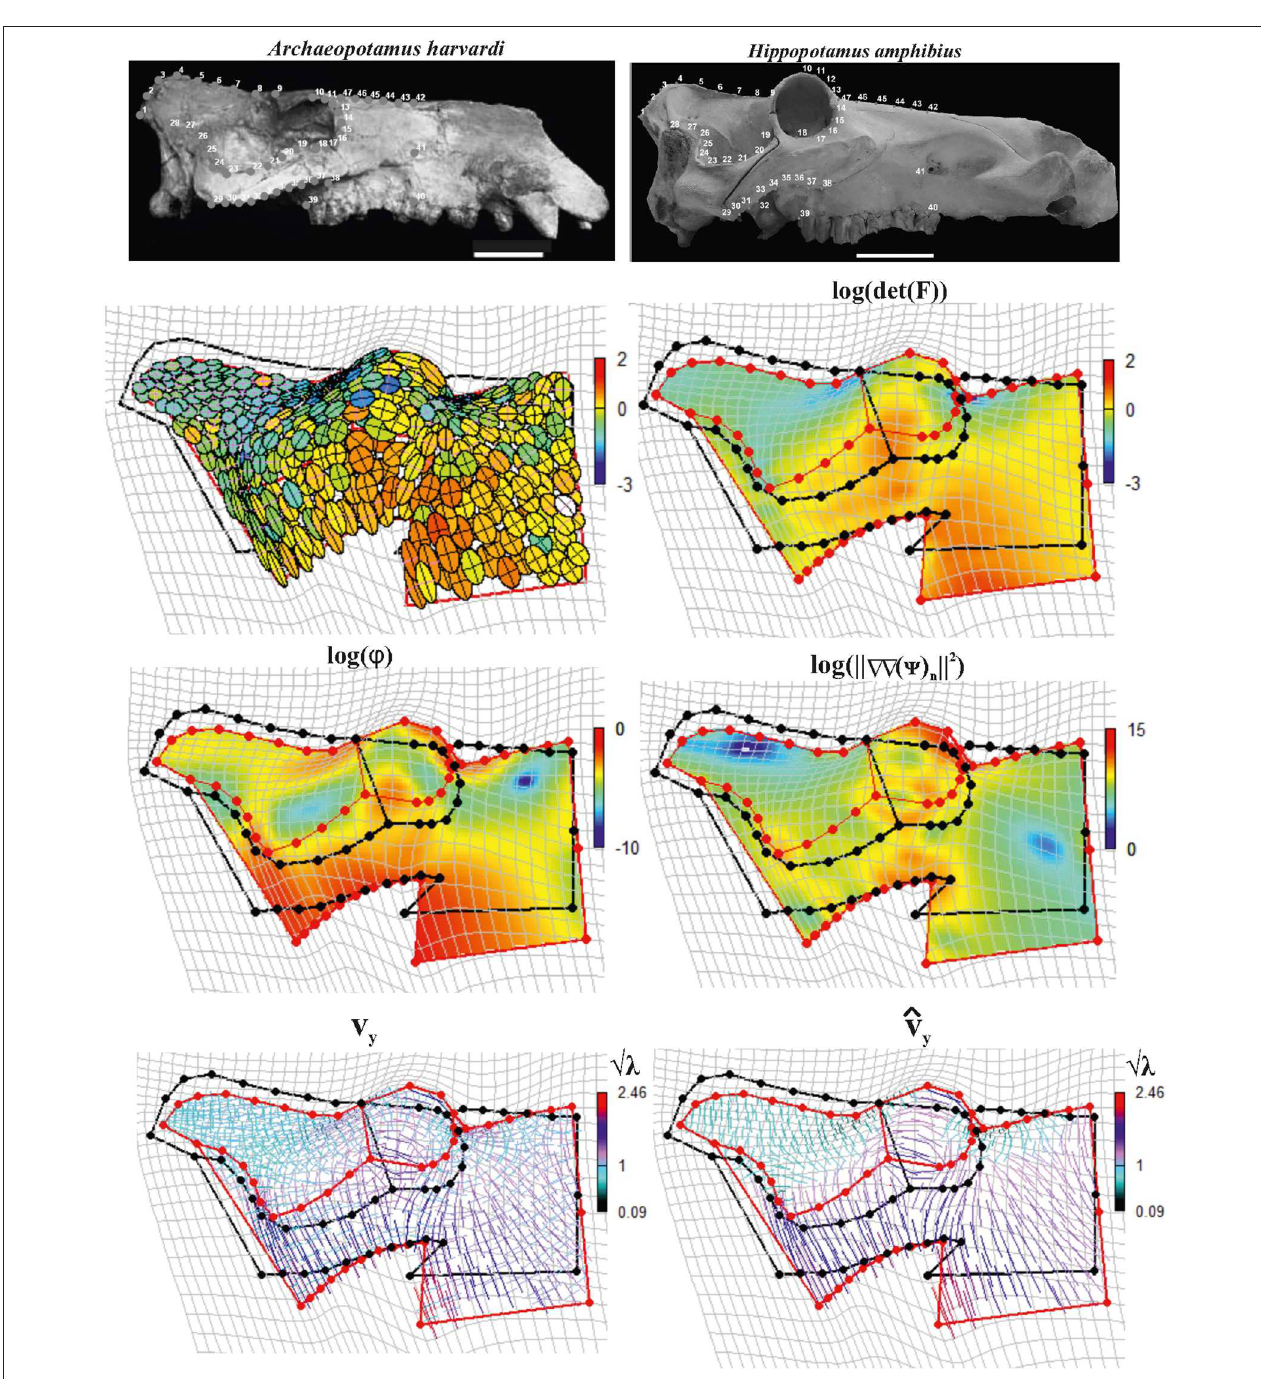
FIGURE 12 | Local deformations observable between Archaeopotamus harvardi KNM-LT 4 (as source) and Hippopotamus amphibius MSNF 1135 (as target). We show both deformation ellipses obtained using F as well as main metrics derived using approaches explained in the text. In particular, we show log(det( F )), log( φ ), and ( ψ ) n || 2 ). v y and v y are also shown colored according to corresponding values in the interval [ √ λ , log(|| ˆ ∇∇ 1 indicate tensile actions. Source and target shapes were aligned via OPA. Scales equal 10cm. KNM, Kenya National Museum; MSNFS, Museo di Storia Naturale di Firenze, sezione di Zoologia La